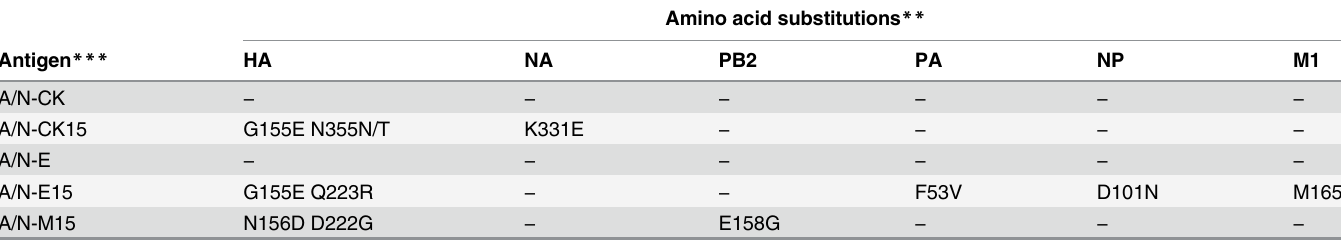
Table 3. Amino acid substitutions in cell-, egg- or mouse-passaged A/N * .